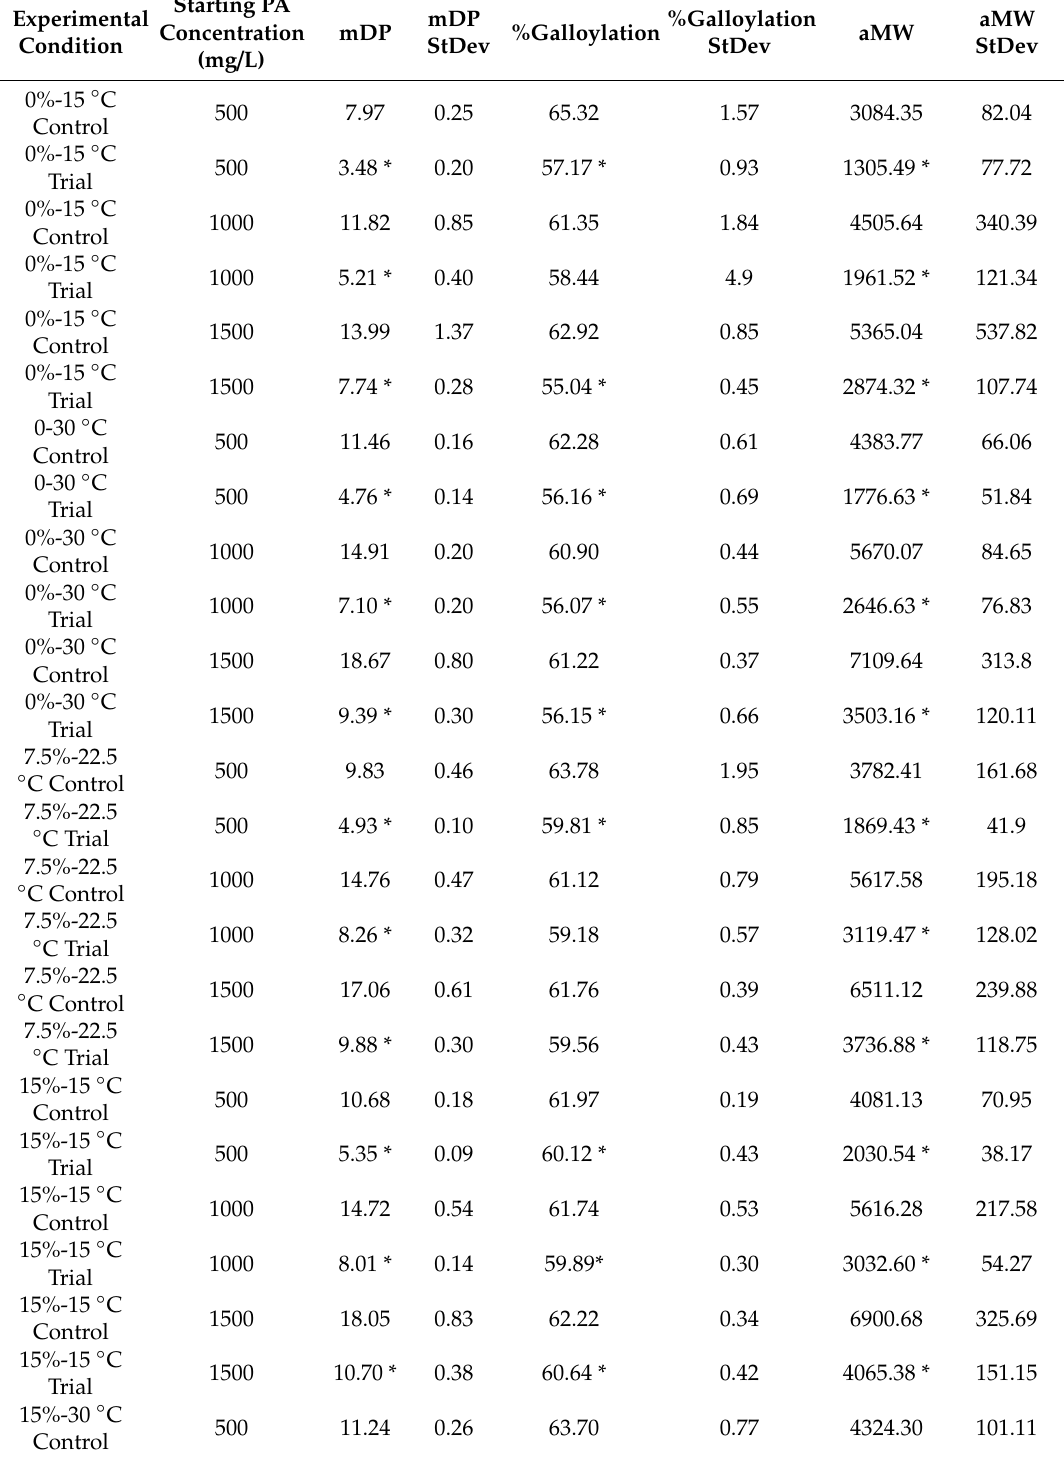
Table A1. Phloroglucinolysis results from PA–anthocyanin solutions after 1440 min of incubation ( n = 6 for each sample). * = significant di ff erence in average measurements between control and trial samples of the same EtOH–temperature conditions ( p < 0.05). mDP = mean degree of polymerization, aMW = average molecular